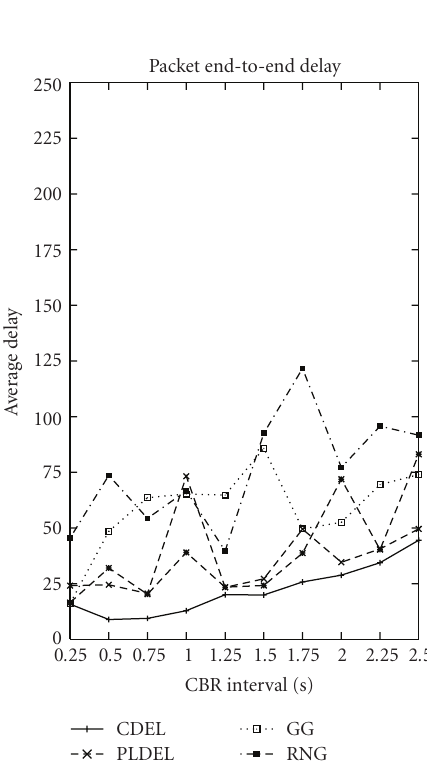
Figure 8: Average hop count.